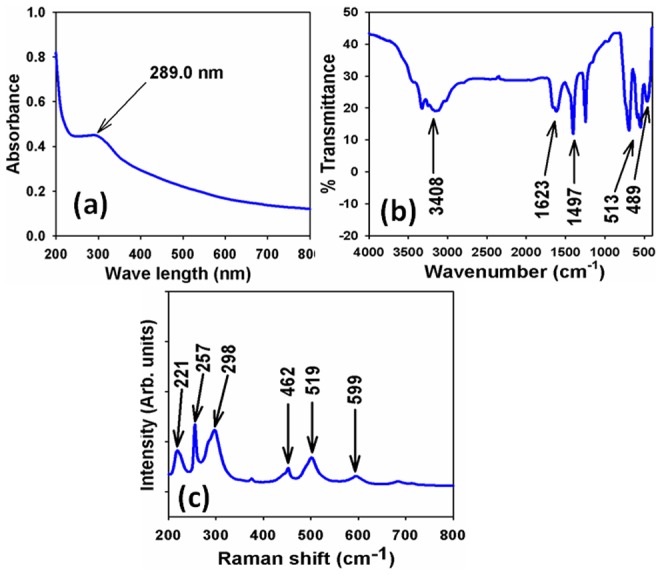
(a) UV/visible, (b) FT-IR, and (c) Raman spectroscopy of as-grown Sb2O3 doped ZnO MFs at room conditions.